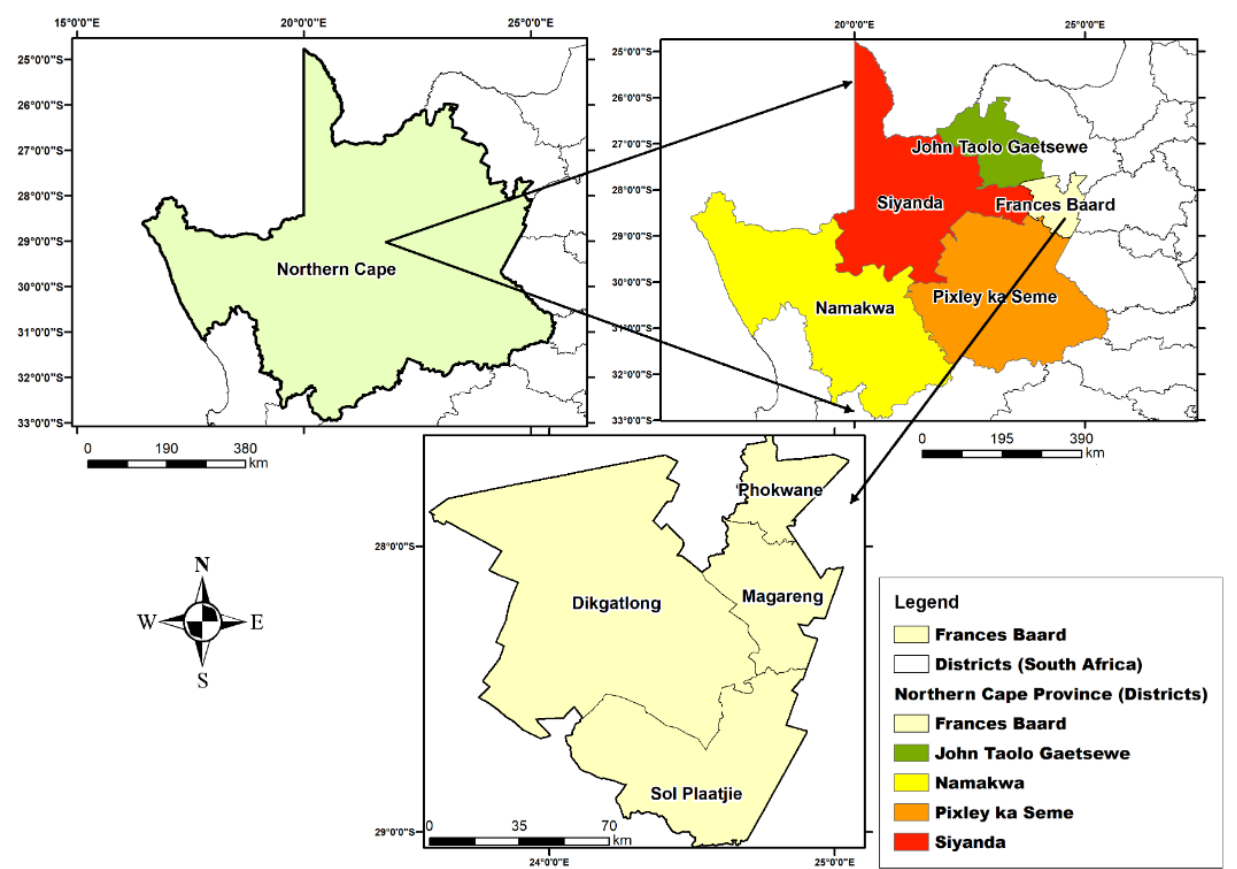
Figure 2. Maps of Northern Cape Province, the district municipalities of the Northern Cape, and the four local municipalities of Frances Baard District Municipality (FBDM). Source: FBDM [42].